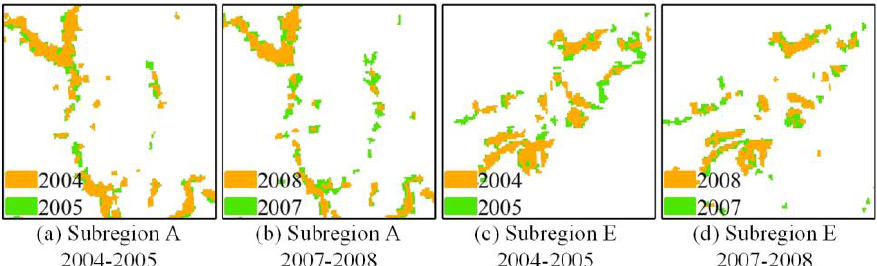
Figure 11. Temporal variation in local detailed paddy rice map at ( a ) subregion A from 2004 to 2005, ( b ) subregion A from 2007 to 2008, ( c ) subregion E from 2004 to 2005, and ( d ) subregion E from 2007 to 2008.